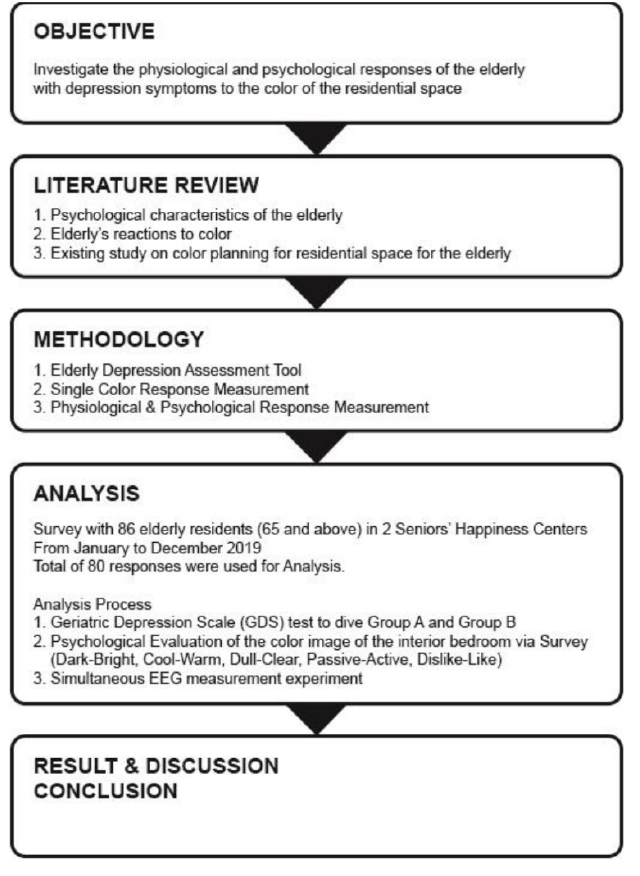
Figure 1. Research process: objective, literature review, methodology, analysis, result, discussion, and conclusion.